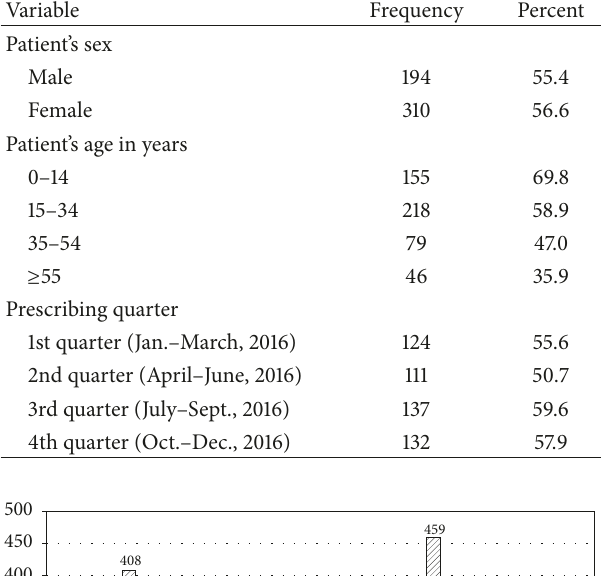
Table 1: Patient-related information of prescriptions dispensed at health centers in Addis Ababa, January 1–December 31, 2016.